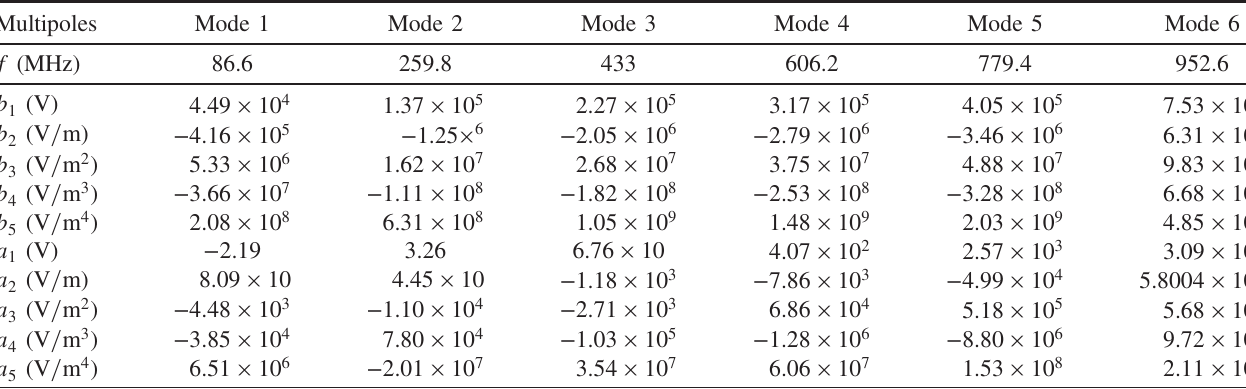
TABLE III. The multipole field coefficients of a harmonic kicker as evaluated based on the circle with 10 mm radius in hexahedral meshing. The coefficients are evaluated based on kick voltage of 25 kV for each mode.